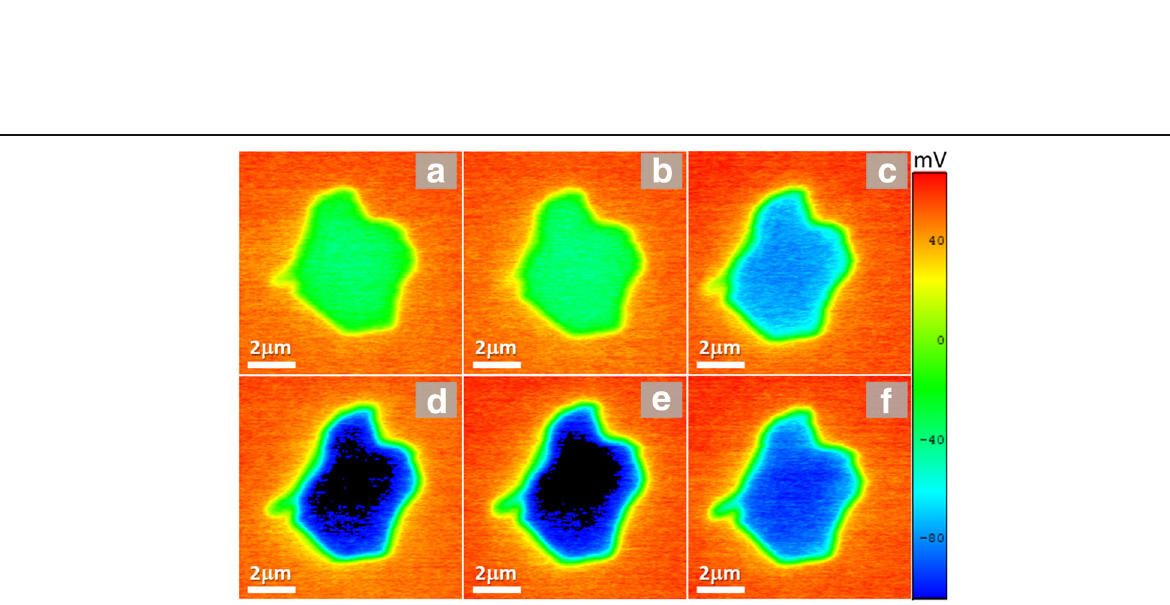
Fig. 8 SKPFM maps of the contact potential difference between PtIr tip and GO flake on Ni substrate: initial ( a ) and after annealing for 15 min at 80, 100, 120, 140, and 180 °C ( b – f ), correspondingly. Ni substrate used for reference in the SKPFM